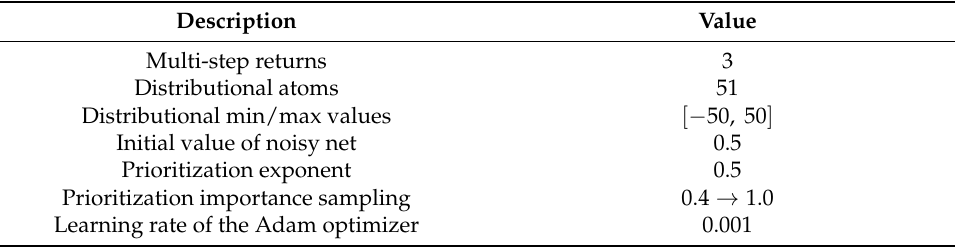
Table A1. Algorithm-related parameters of